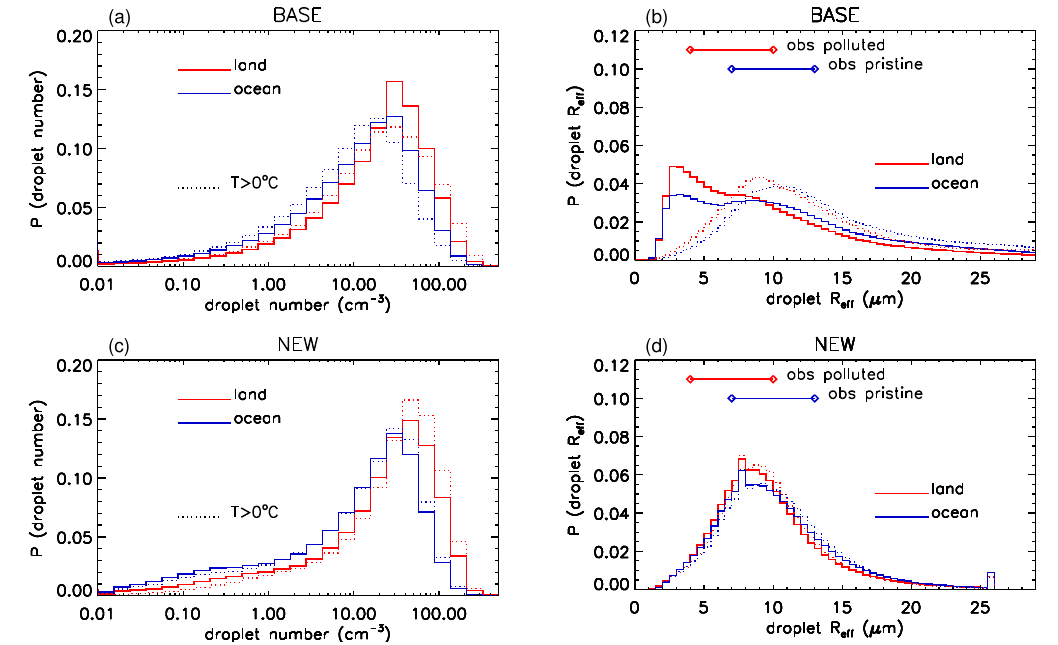
Fig. 4. Global PDFs of in-cloud droplet number and droplet effective radius over land and over oceans for clouds with liquid water content above 10 − 6 kgm − 3 . Ranges of effective droplet radii from observations (lines and diamonds) under pristine (7–13µm), and polluted (4– 10µm) conditions are taken from Gettelman et al. (2008) and are based on Bower and Choularton (1992), Martin et al. (1994), Brenguier et al. (2003), and Pawlowska et al. (2006). Dotted lines represent the PDFs for grid-points where T > 0 ◦ C. The model sampling frequency is